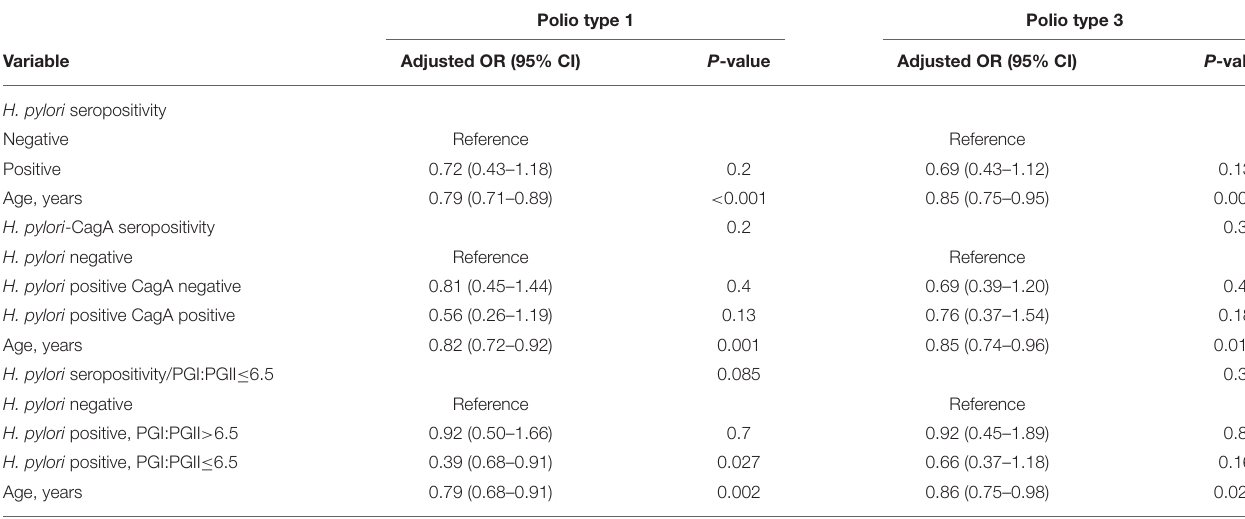
TABLE 4 | Age-adjusted propensity score inverse probability weighted models of the association between H. pylori seropositivity and high serum neutralizing antibody level (a titer > 1:2,048) to poliovirus type 1 and 3 vaccine strains.